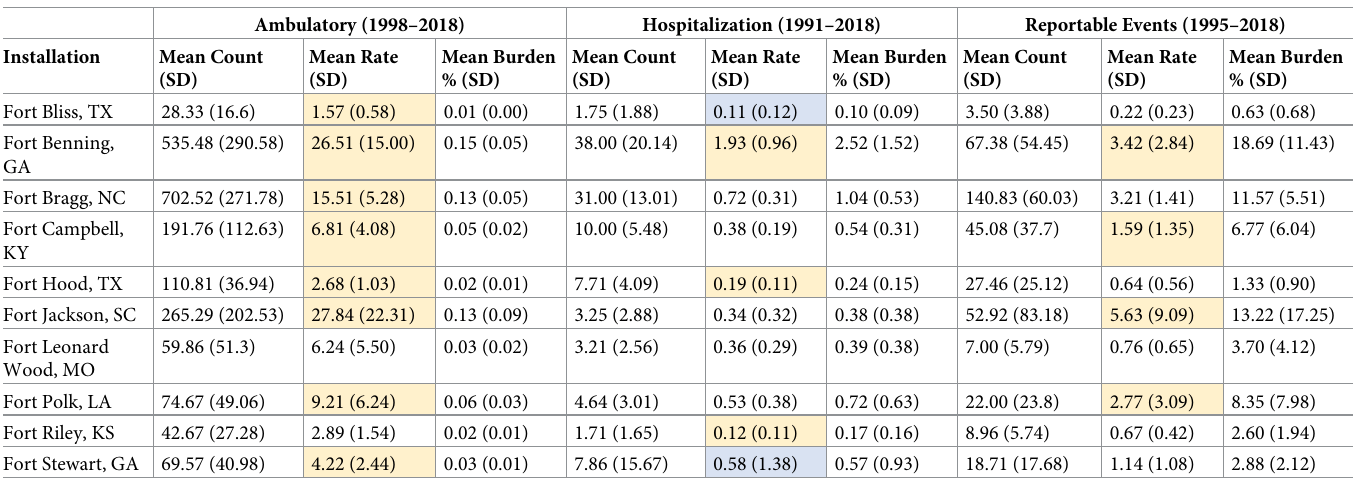
Table 2. Heat stress illness outcomes (all HSI types).